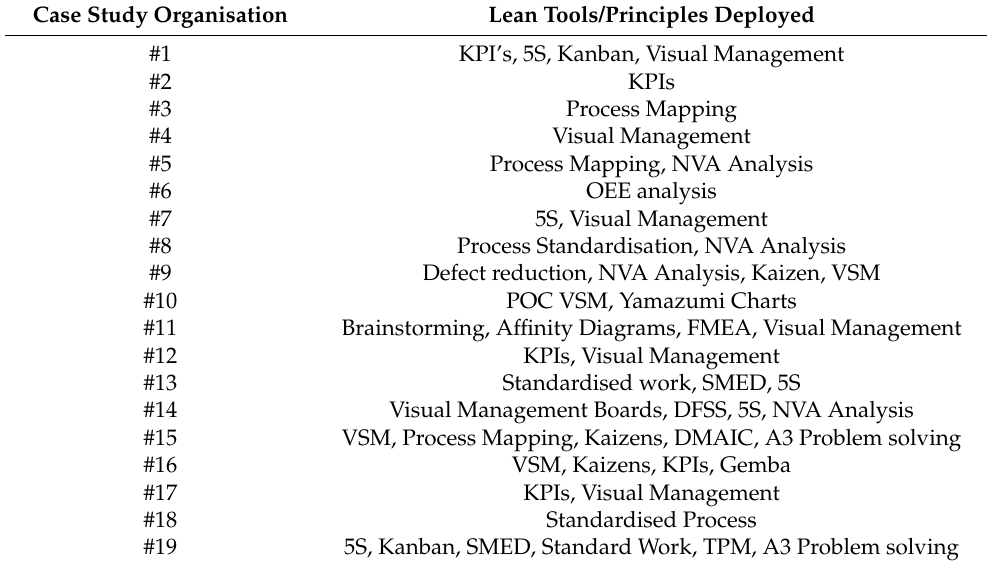
Table 4. Lean Tools and Principles deployed within Irish